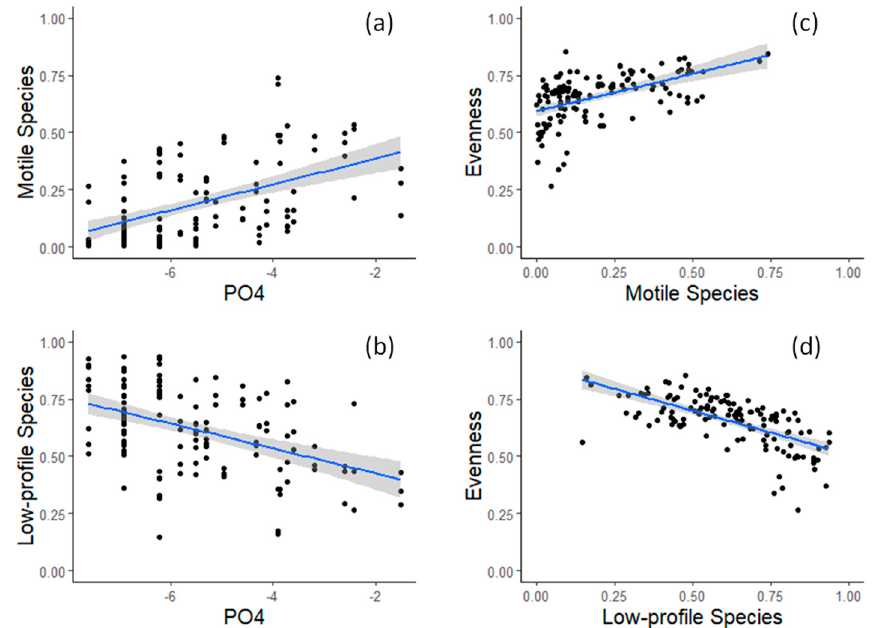
Figure 3. Relationship between PO4 concentration and diatom guilds: ( a ) relative abundance of motile species; ( b ) relative abundance of low profile species; and ( c , d ) the same diatom guilds and evenness J.